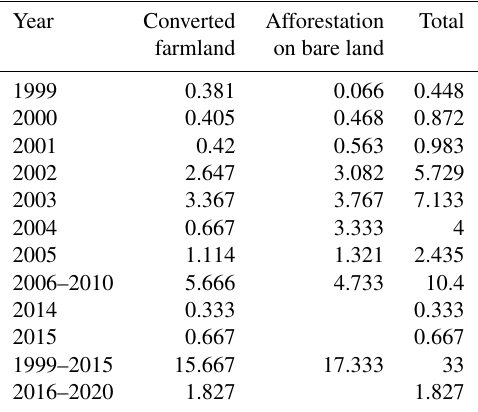
Table 5. Converted farmland and reforested bare land included in China’s Grain for Green Program (millions hectares) (Office of Converting Farmland to Forestry, State Forestry Administration of China, 2014,